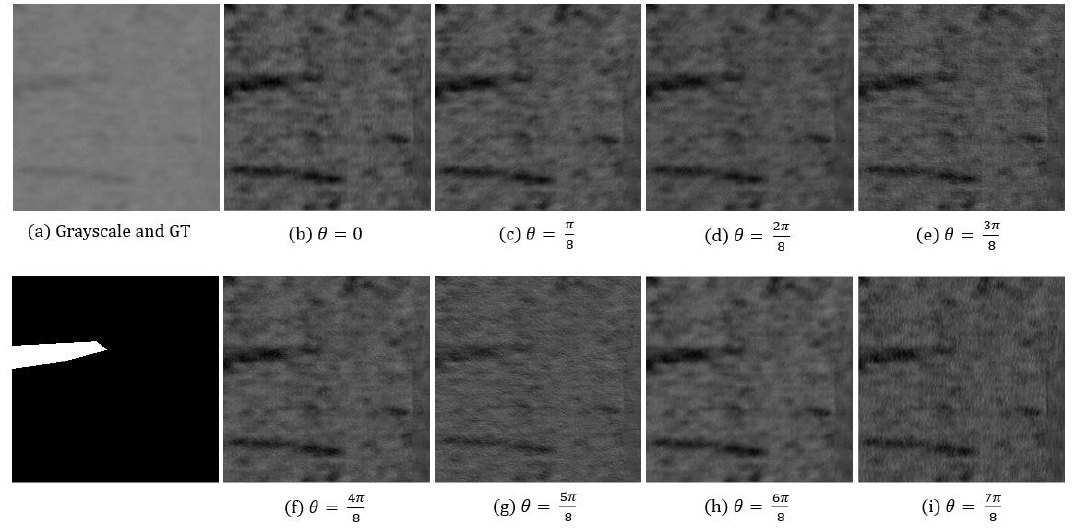
Figure 2. Gabor image according to phase in MT stain image. ( a ) gray-scale inspection image; from ( b – i ) Gabor filter images according to phase.